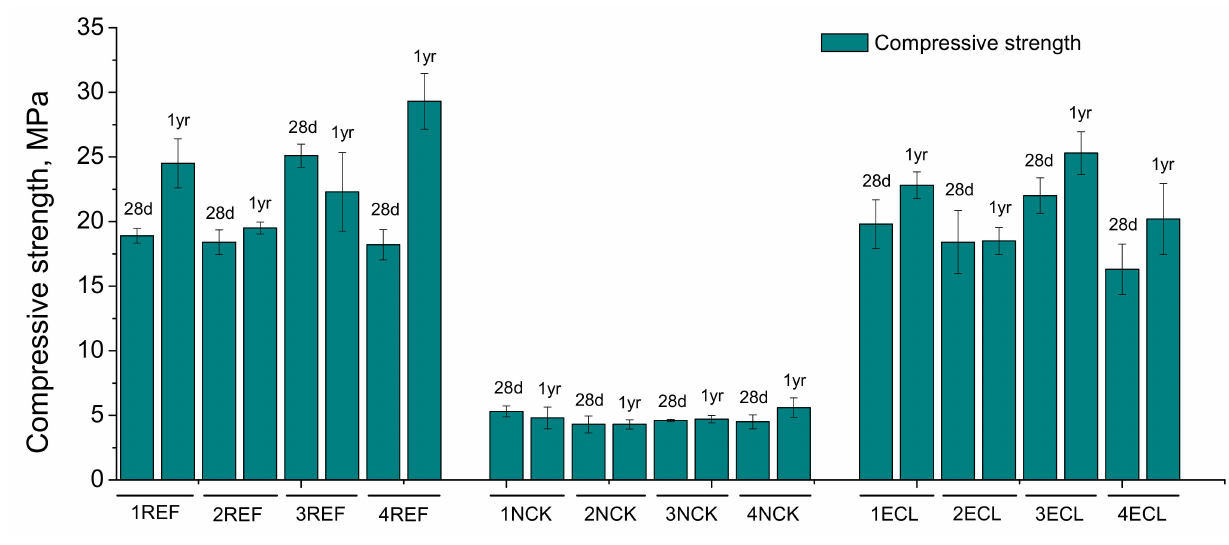
Figure 7. Compressive strength results for the analyzed series.